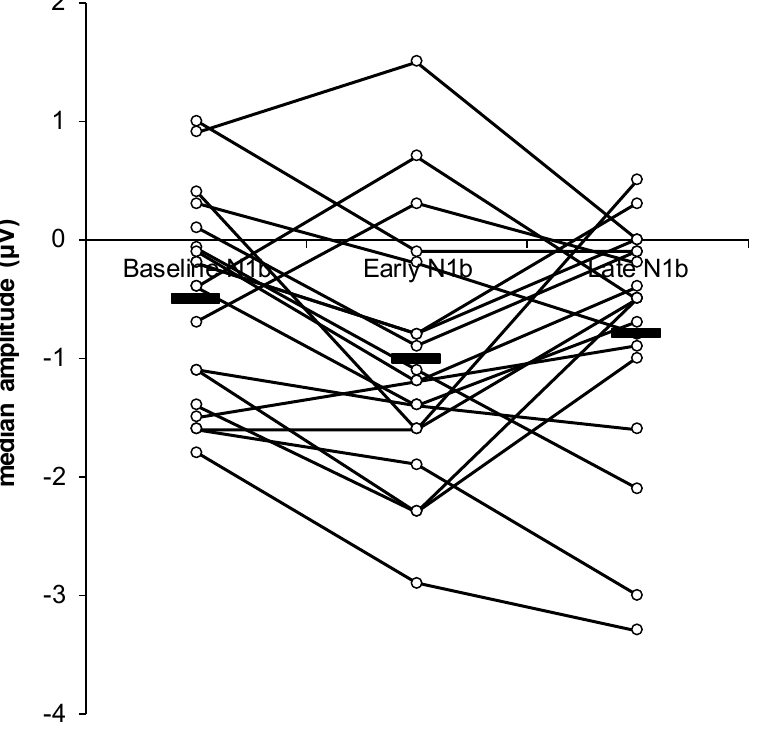
Figure 4. The change of the N1b component over time (baseline, early, and late) for individual participants. The “black line” shows the median amplitude at each time point.